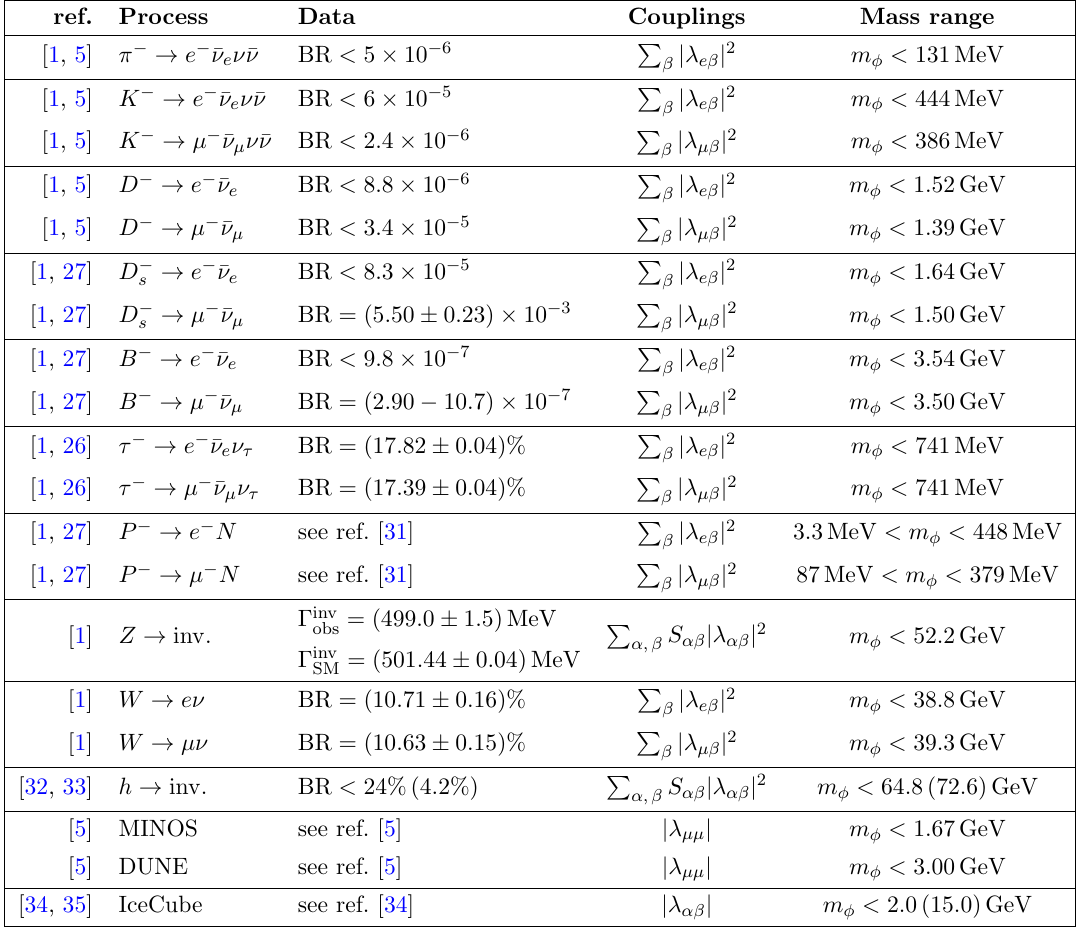
Table 1 . Summary of current and future experimental data which can be used to set limits on the couplings j (cid:21) (cid:11)(cid:12) j (with ‘ = e; (cid:22) ) or their combinations. The last column shows the relevant m (cid:30) ranges (see (cid:12)gures 2{4 and 8{10). For the limits from invisible Z and h decays, the symmetry factor S (cid:11)(cid:12) = 1 (1 = 2) for (cid:11) 6 = (cid:12) ( (cid:11) = (cid:12) ). For the invisible Higgs decay and IceCube data, the numbers in the parentheses are respectively the expected sensitivity at the HL-LHC and IceCube-Gen2. The limits not collected in this table are either weaker or not relevant for m (cid:30) > 100 MeV. The branching fraction (BR) upper limits are at 95% con(cid:12)dence level (C.L.), whereas the error bars quoted for the BR measurements are at 1 (cid:27) C.L.; see text for more details.